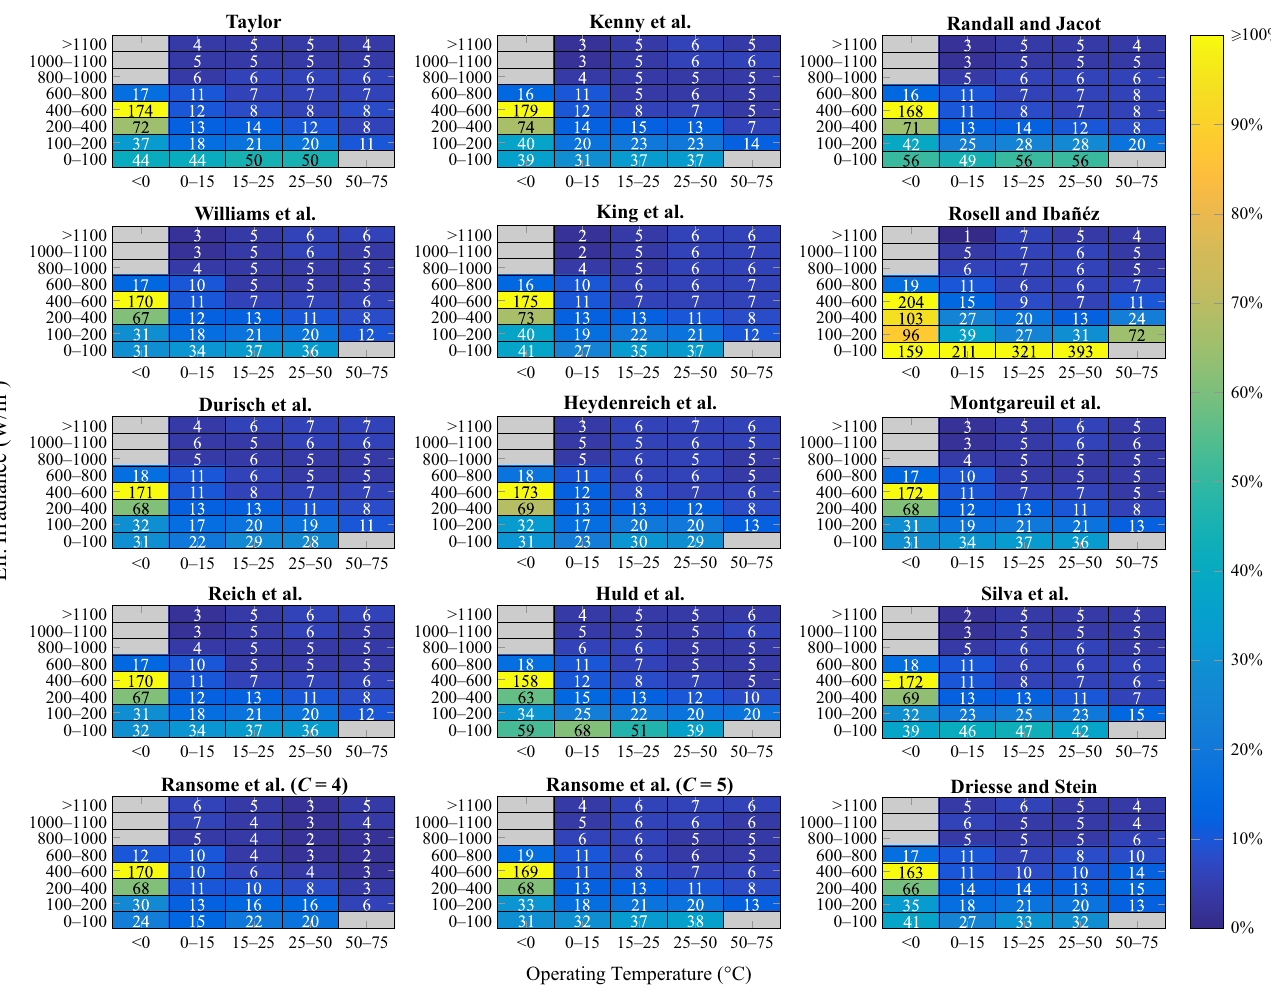
Figure 6. RMSE values (%) calculated from the results obtained by each empirical model for the different range of operating conditions verified for the PV modules under study, when they were applied when considering the proposed